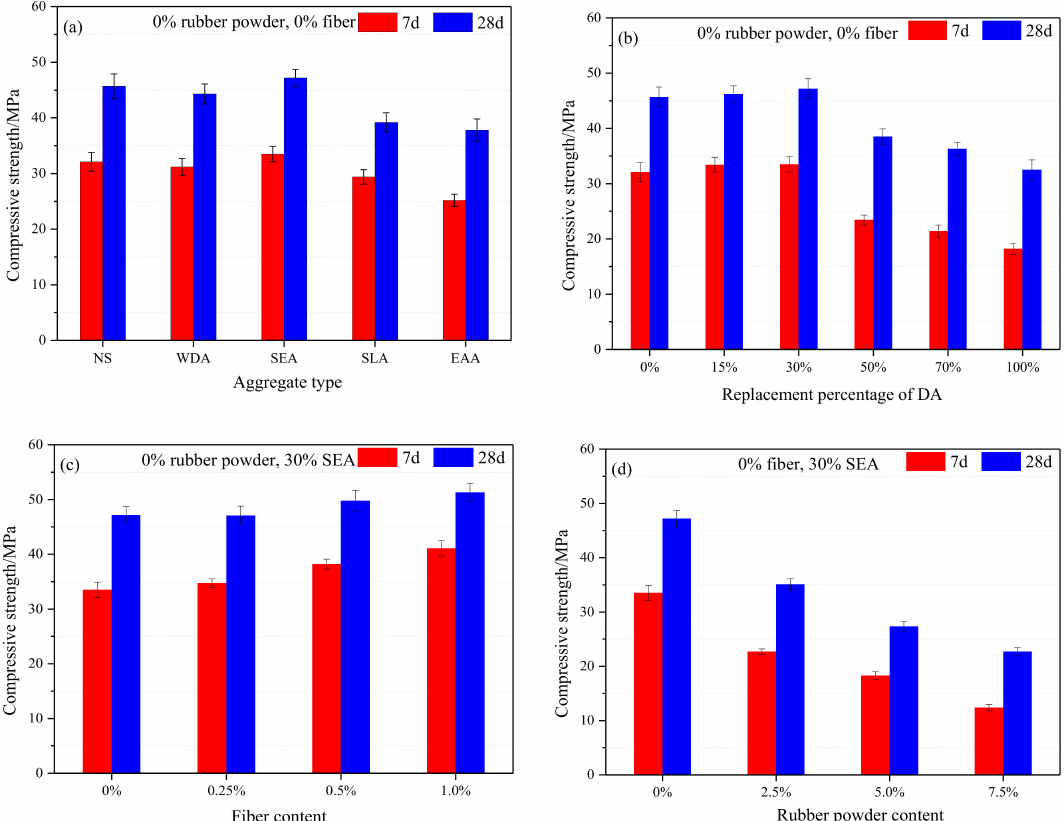
Figure 7. Compressive strength of cement mortar: ( a ) aggregate type; ( b ) replacement percentage of DA; ( c ) fiber content, and ( d ) rubber powder